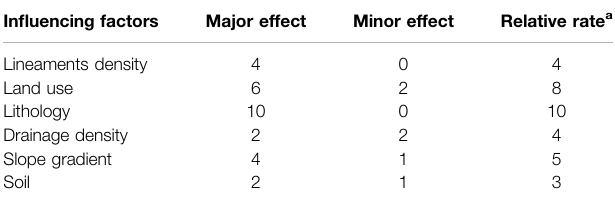
TABLE 3 | The process of determining the relative rate of each factor (modi fi ed from Selvam et al., 2016). In fl uencing